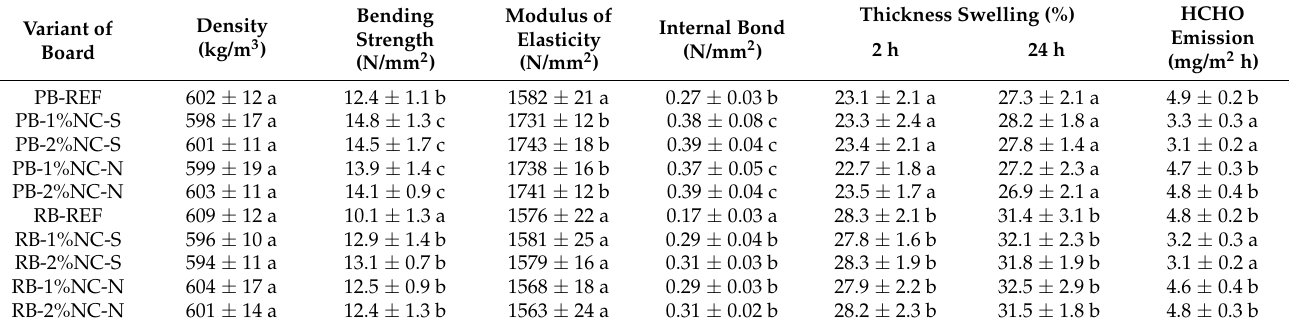
Table 6. Properties of manufactured